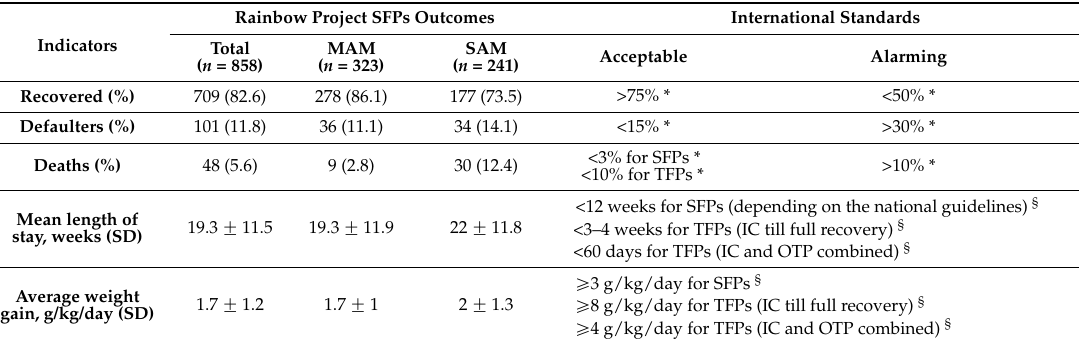
Table 2. Rainbow Project SFPs outcomes reported as for total, MAM and SAM, and compared with International Standards.